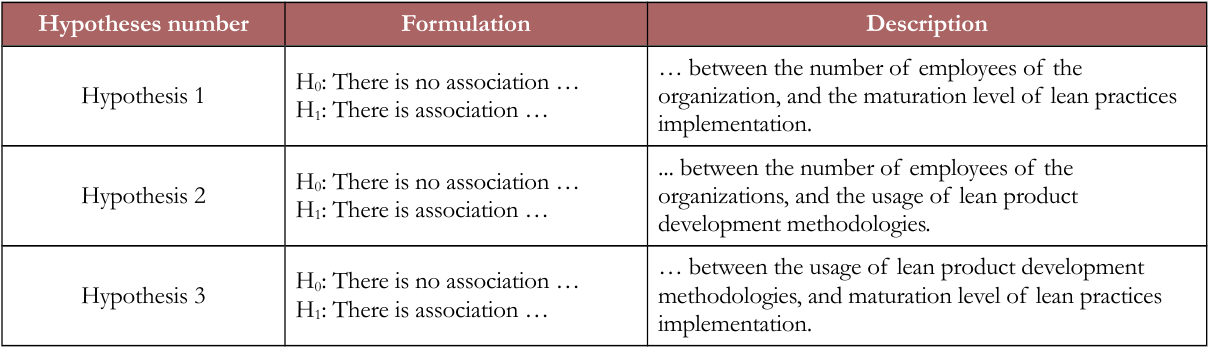
Table 8. Hypothesis